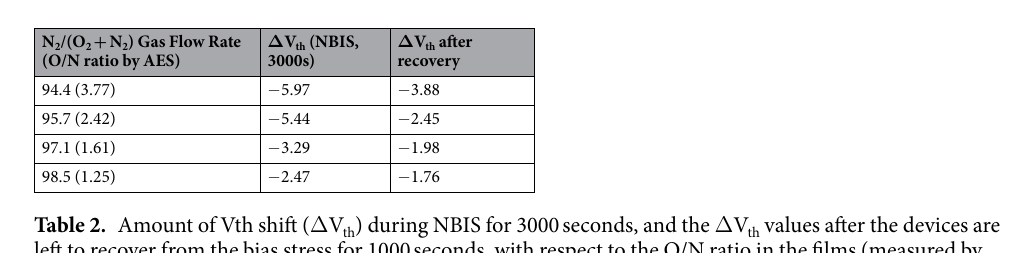
Table 2. Amount of Vth shift ( Δ V th ) during NBIS for 3000 seconds, and the Δ V th values after the devices are left to recover from the bias stress for 1000 seconds, with respect to the O/N ratio in the films (measured by AES). The Δ V th values are all measured with reference to the initial V th values before the NBIS